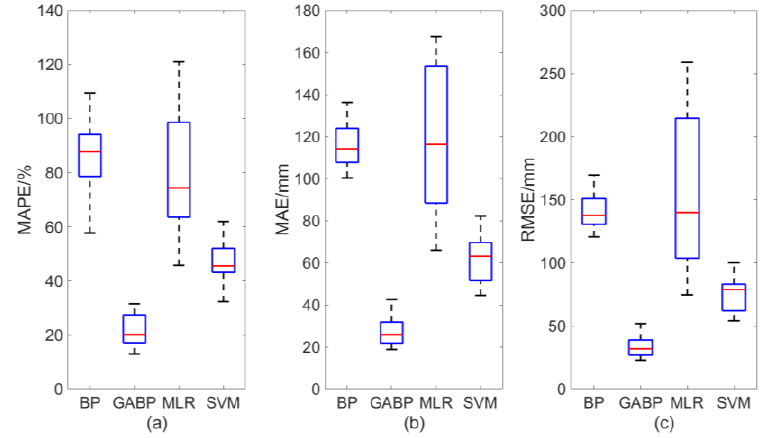
Figure 6. Box diagrams of the maximum, minimum and average errors of predicted summer precipitation using the three methods for the YHRB, where ( a – c ) are for MAPE, MAE and RMSE, respectively. Table 1. Basin-averaged evaluation measures of various models, where each model is denoted with a subscript that contains two numbers; the former and latter numbers are respectively for the month of factors selected and the month of forecasted precipitation; e.g., M 12-6 means the model